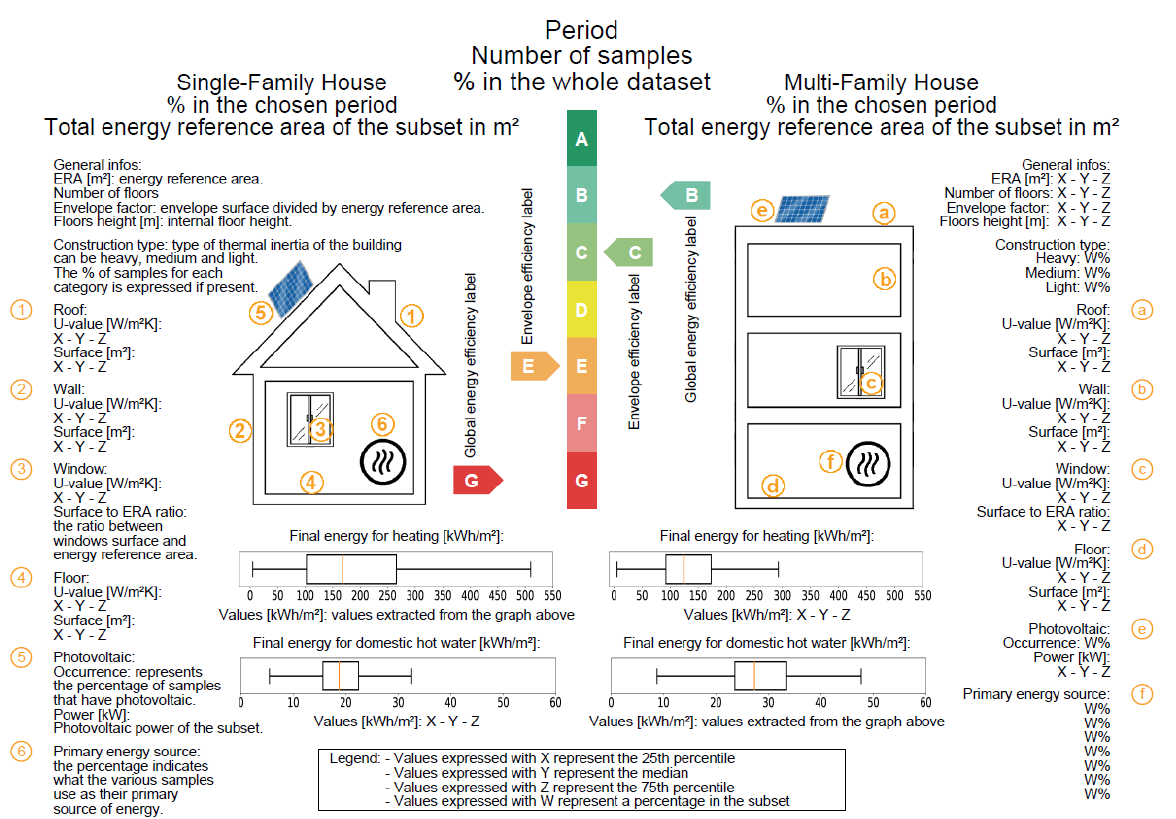
Figure A1. Archetype description sheet legend.